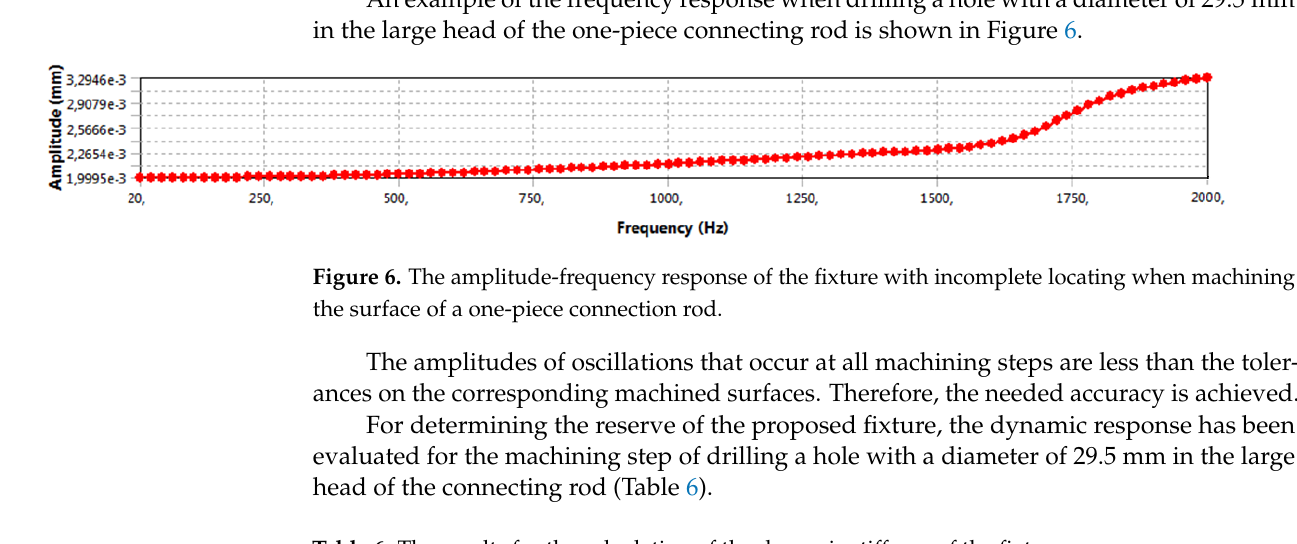
Table 6. The results for the calculation of the dynamic stiffness of the